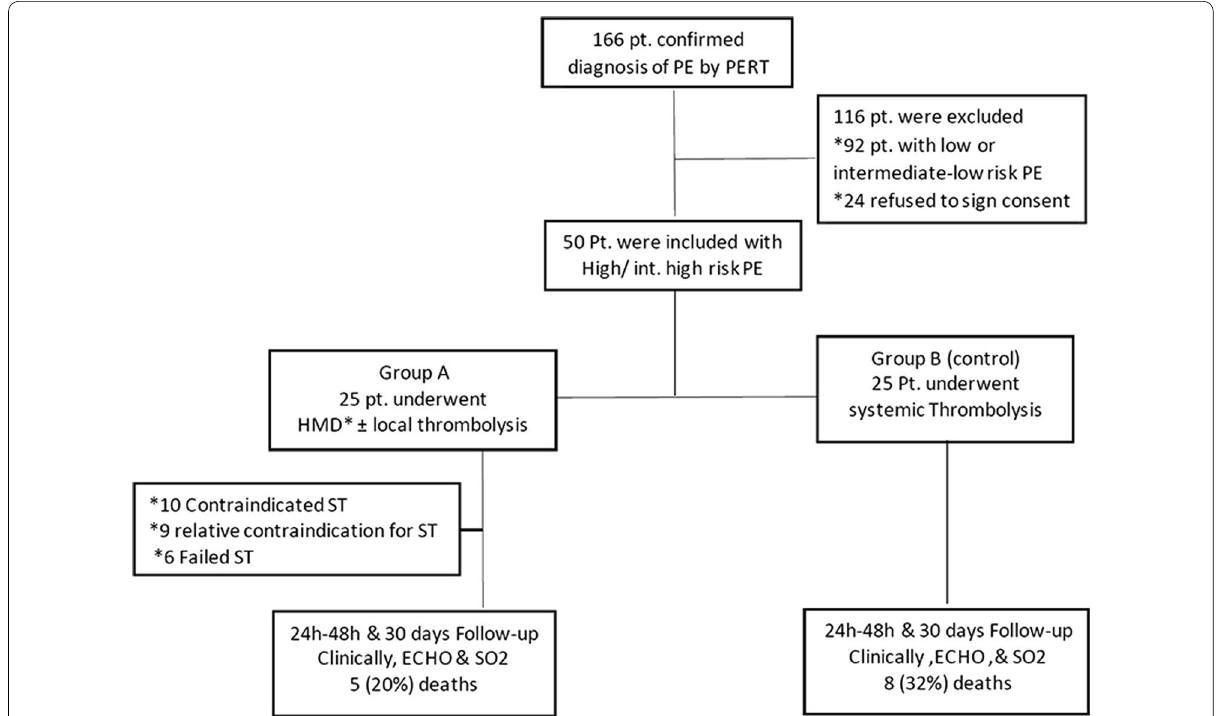
Fig. 1 Flowchart of the study population. All 166 patients were first diagnosed by PERT who decide the treatment strategy. HMD: hydro‑mechanical defragmentation, ST systemic thrombolysis, PERT pulmonary embolism response team, PE: pulmonary embolism, = = pt. patients, ECHO echocardiography, SO2 oxygen = = =